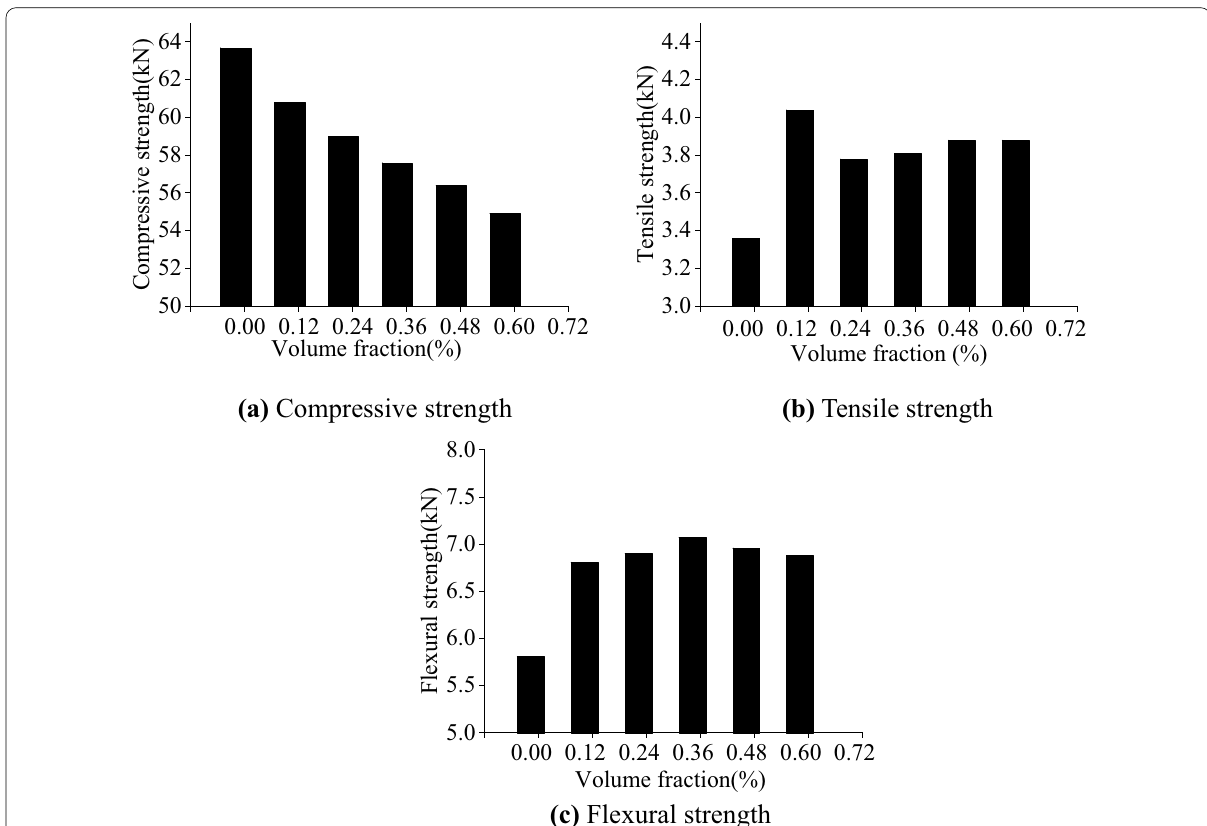
Fig.5 Relationship between strengths of HFRC and volume fractions. a Compressive strength. b Tensile strength. c Flexural strength.